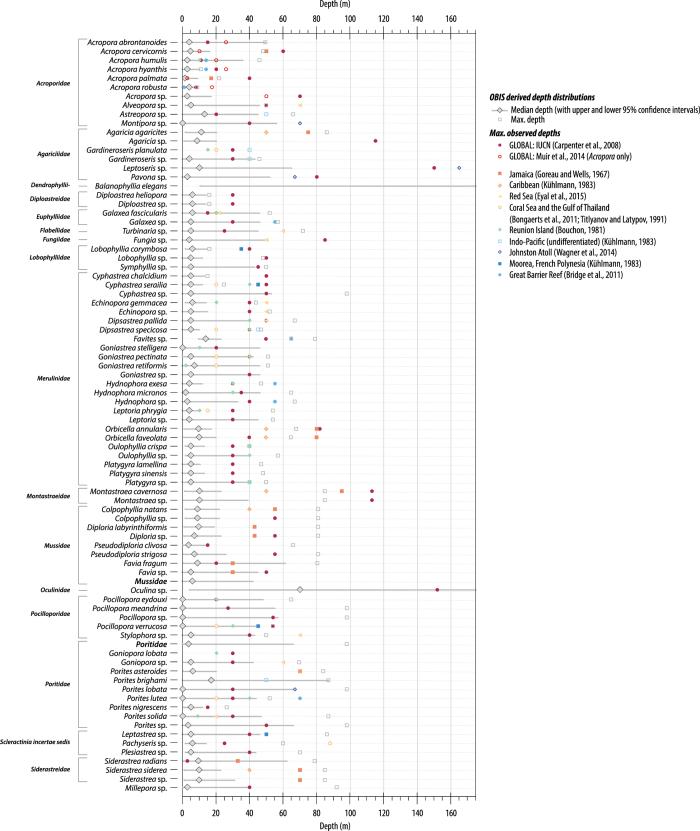
Coral depth distributions.Median (grey, filled diamond) and 95% confidence intervals (grey horizontal bars) for the ecologically derived depth distributions. The ICUN89 global estimates of maximum depth (dark red, filled circles) and those derived for Acropora sp.90 (red, open circles) are given for comparison. Also plotted are the maximum depths for certain recorded at various locations: Jamaica75 (orange, filled squares); the Caribbean92 (orange, open diamonds); The Red Sea97 (yellow, filled triangles); the Coral Sea94 and Gulf of Thailand93 (yellow, filled circles); Reunion Island91 (green, filled diamonds); the Indo-Pacific96 (blue, open squares); Johnston Atoll92 (dark blue, open diamonds); Moorea, French Polynesia92 (dark blue, filled squares) and; the Great Barrier Reef95 (blue, filled circles).